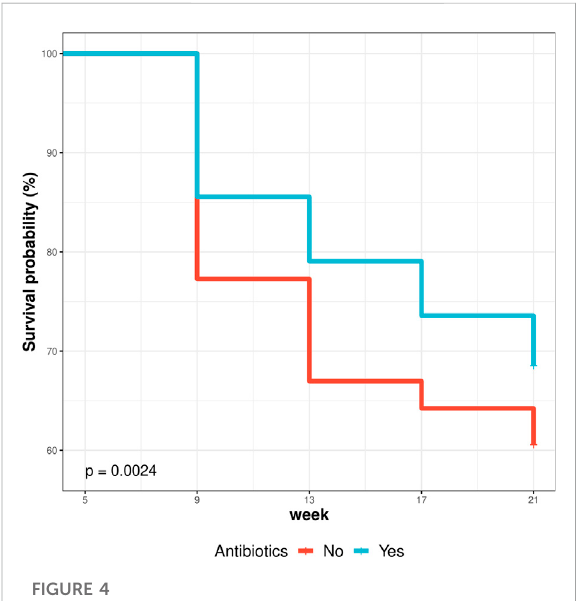
FIGURE 4 Effect of antibiotics usage on survival performance of birds (5 – 21